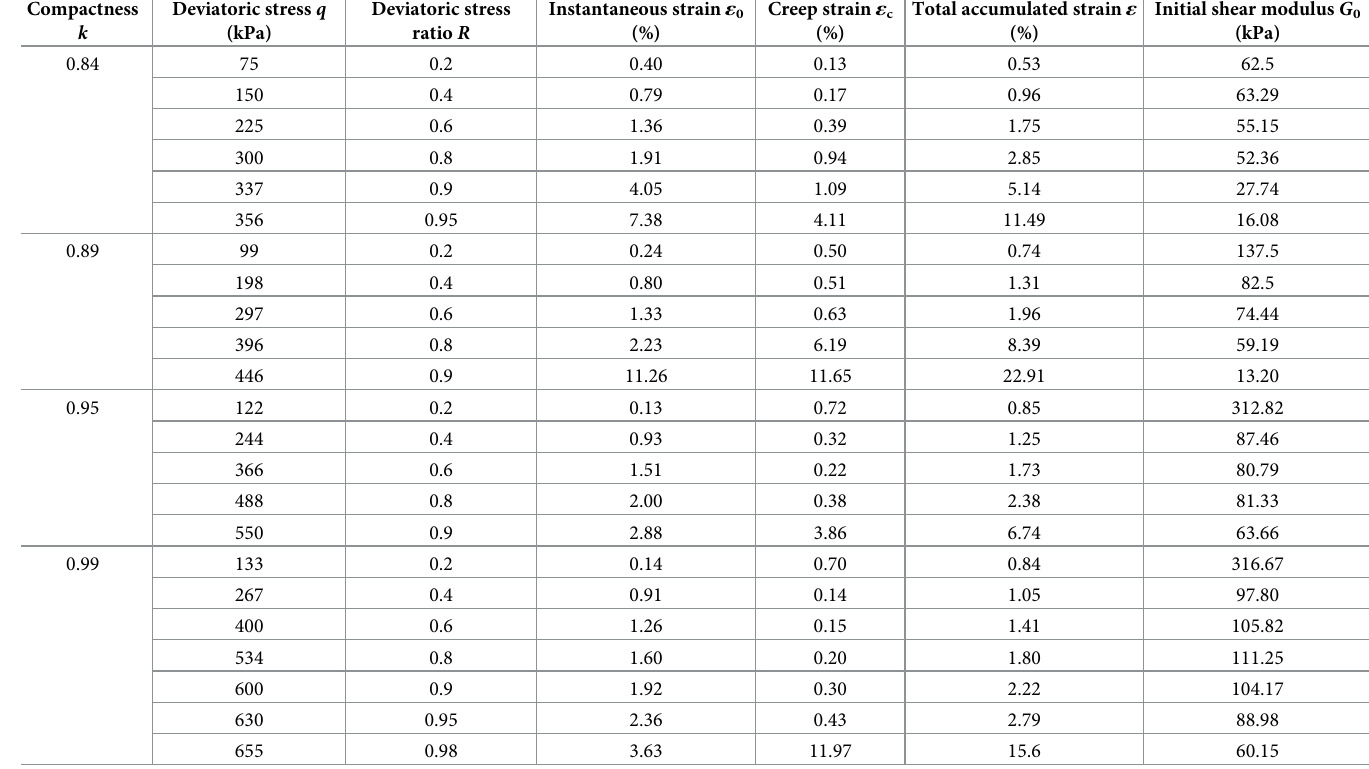
Table 3. The strain values of the remoulded loess under various levels of compactness. Compactness